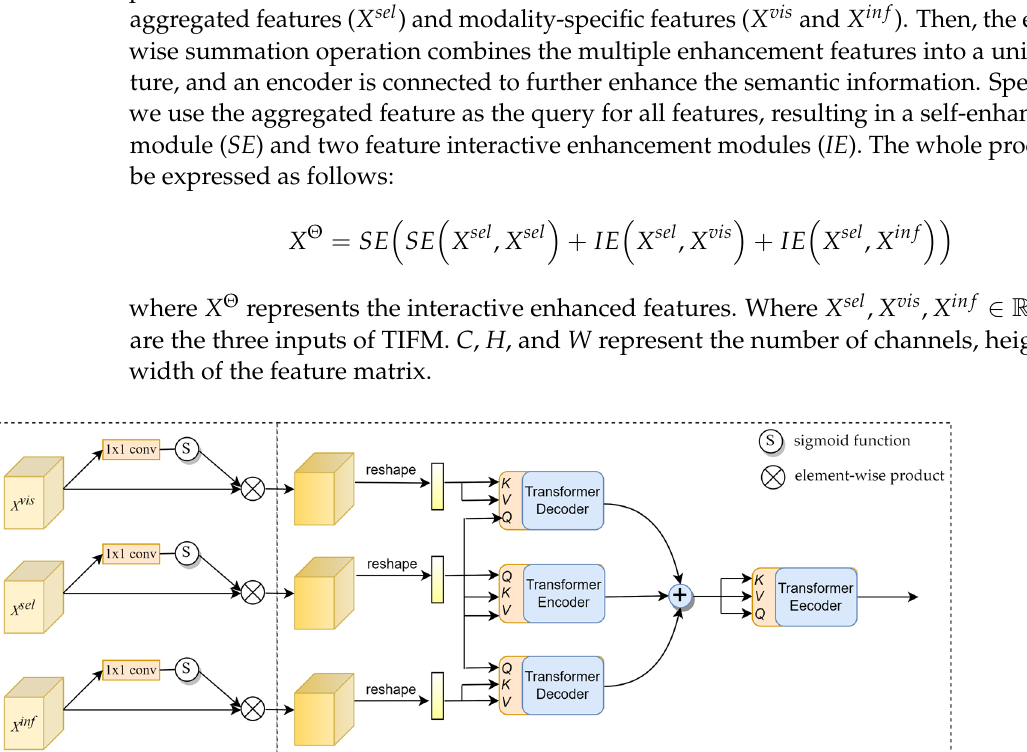
Figure 4. Speci fi c structure of the encoder and decoder.